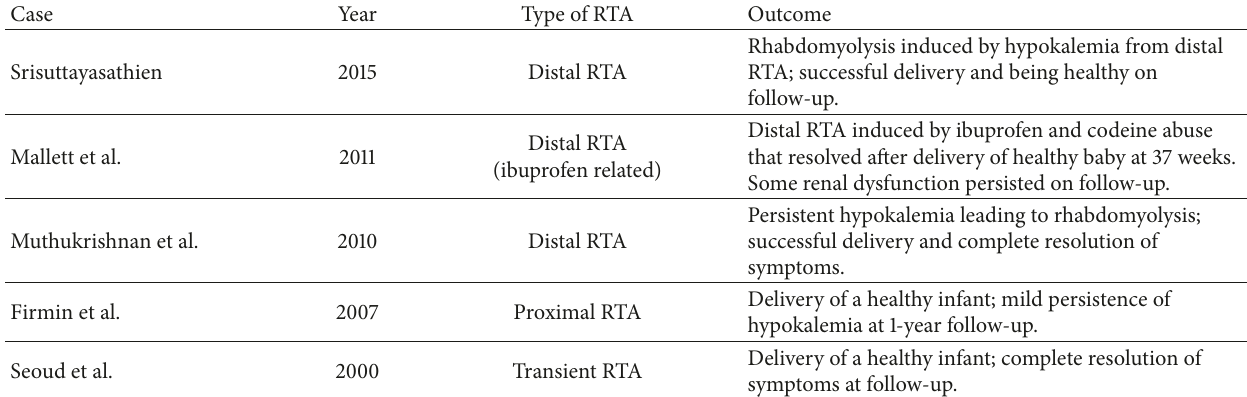
Table 1: Reported cases and outcomes of renal tubular acidosis (RTA) that presented during pregnancy [2, 3, 7–9]. Case Year Type of RTA Outcome Rhabdomyolysis induced by hypokalemia from distal 2015 Distal RTA RTA; successful delivery and being healthy on follow-up. Distal RTA induced by ibuprofen and codeine Distal RTA 2011 (ibuprofen related)